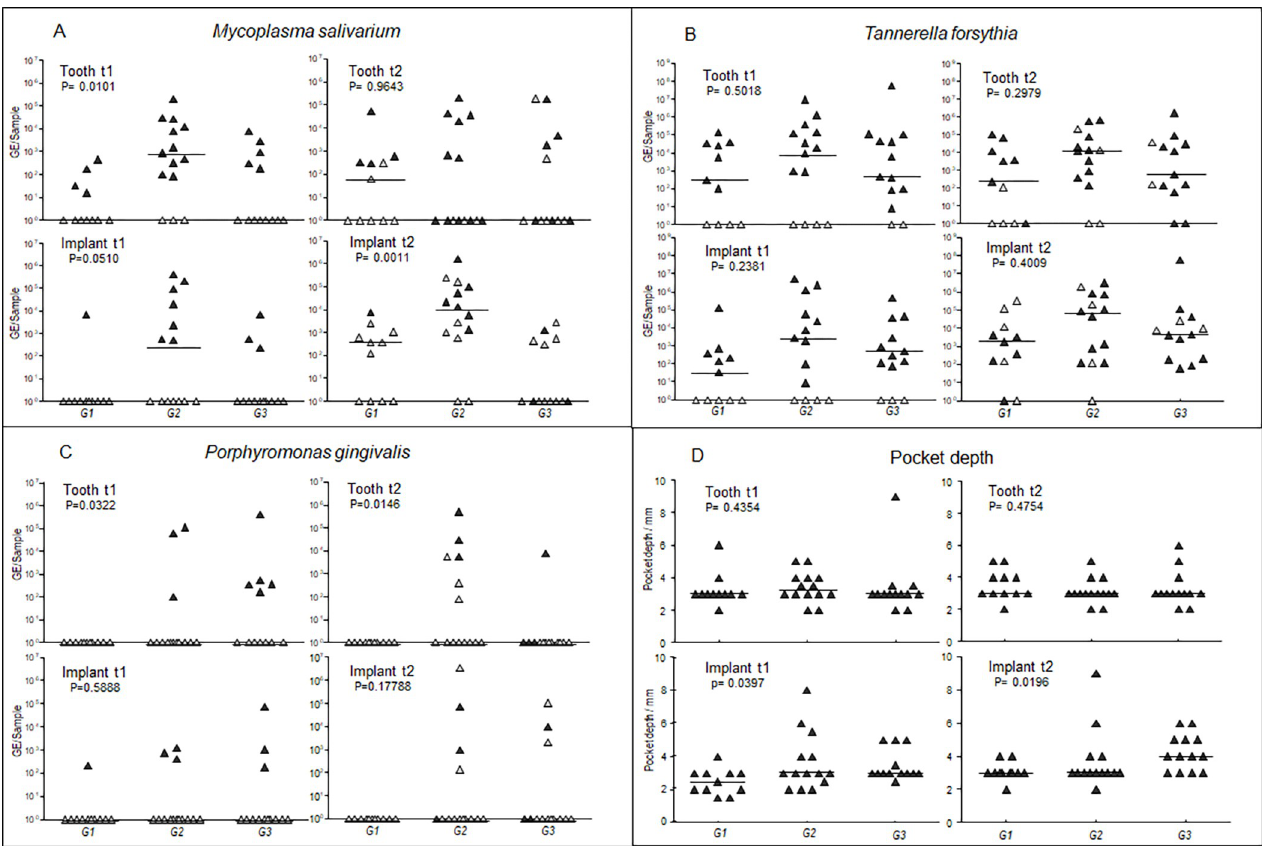
Fig 1. Abundance of bacterial species and gingival pocket depth by underlying augmentation material. Scatter plots of the bacterial quantity of (A ) Mycoplasma salivarium , (B ) Tannerella forsythia and (C) Porphyromonas gingivalis; indicated as genome equivalents per sample (GE/sample) and of the (D) pocket depth /mm in the peri-implantary sulcus compared to the opposite tooth, over time in the different augmentation groups. G1: Group 1, cortical autogenous bone blocks; G2: Group 2, healthy autogenous tooth roots; G3: Group 3, roots from non-preservable tooth; t1: begin of the prosthetic restauration; t2: six months after completing of the prosthetic restauration. ▲ = positive patient sample at time t1; 4 = negative patient sample at time t1. The bars represent